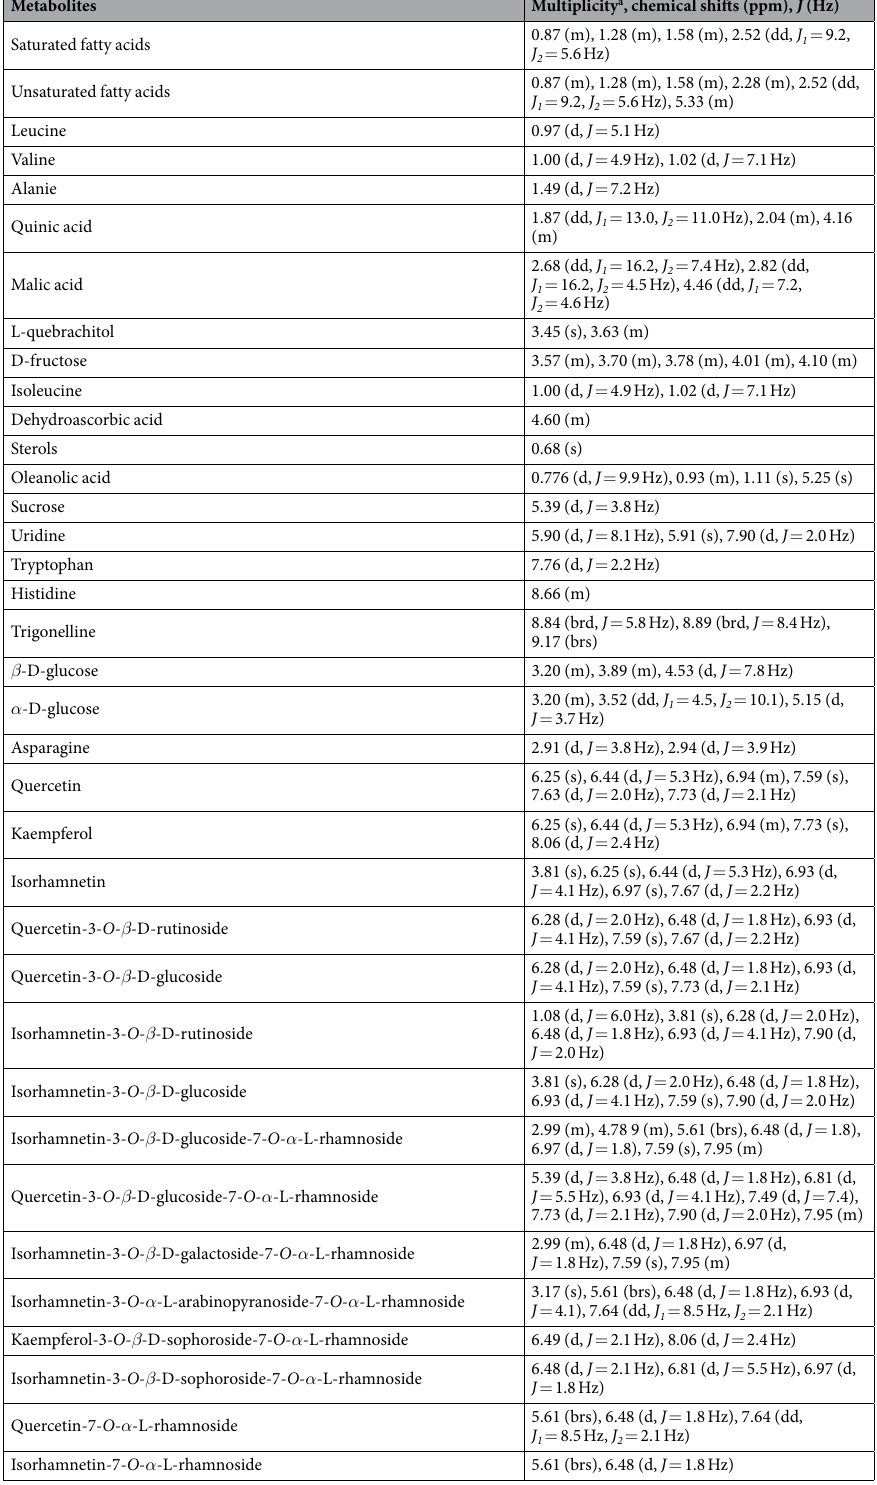
Table 1. Identification of metabolites in berry samples from seven species and seven subspecies of Hippophaë by 1 H NMR spectroscopy. a Multiplicity: s, singlet; d, doublet; t, triplet; and m,